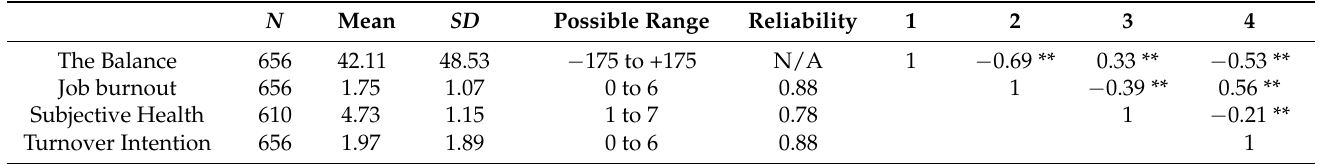
Table 1. Mean values, standard deviations, range and intercorrelations of variables. N Possible